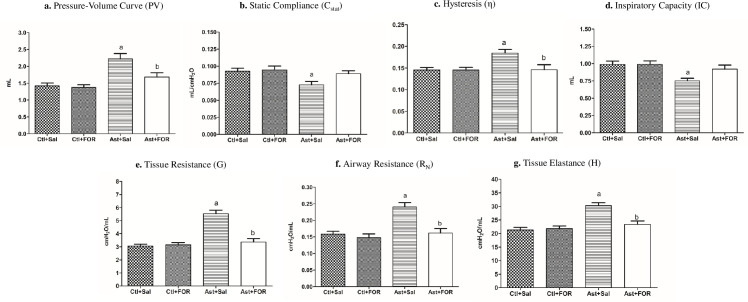
Effect of the FOR811A, a ruthenium nitric oxide donor metallocompound, against experimentally induced asthma in a murine model.The Swiss mice were divided into four groups (n = 10, each): untreated (Ctl+Sal) and treated (Ctl+FOR) control groups, and untreated (Ast+Sal) and treated (Ast+FOR) asthmatic groups. Using an integrated platform for pulmonary mechanic assay, the pressure-volume curve area (PV; expressed in mL; a) and the behavior of static compliance (Cstat; expressed in mL/cmH2O; b), hysteresis (η; c); inspiratory capacity (IC; expressed in mL; d); tissue resistance (G; expressed in cmH2O.s/mL; e); airway resistance (RN; expressed in cmH2O.s/mL; f) and tissue elastance (H; expressed in cmH2O.s/mL; g). Data were expressed as mean ± SEM. a
p<0.05 (Ast+Sal) vs. (Ctl+Sal); b
p<0.05 (Ast+FOR) vs. (Ast+Sal); c
p<0.05 (Ast+FOR) vs. (Ctl+Sal).